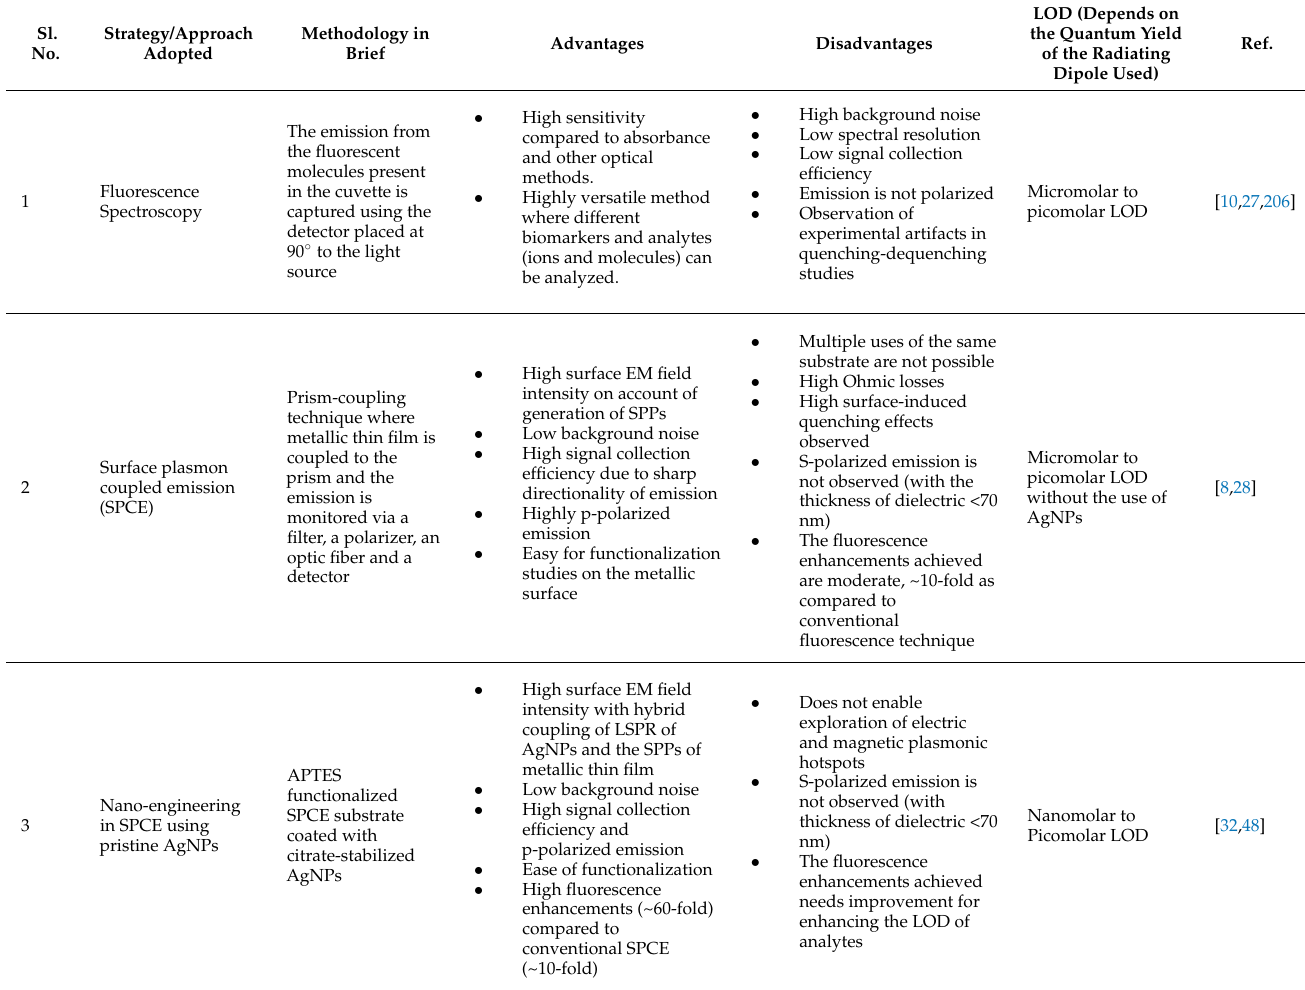
Table 4. Summary table of the comparison of the performance of the recent techniques/strategies developed for biosensing with the SPCE platform, presented along with their limit of detection (LOD), advantages and